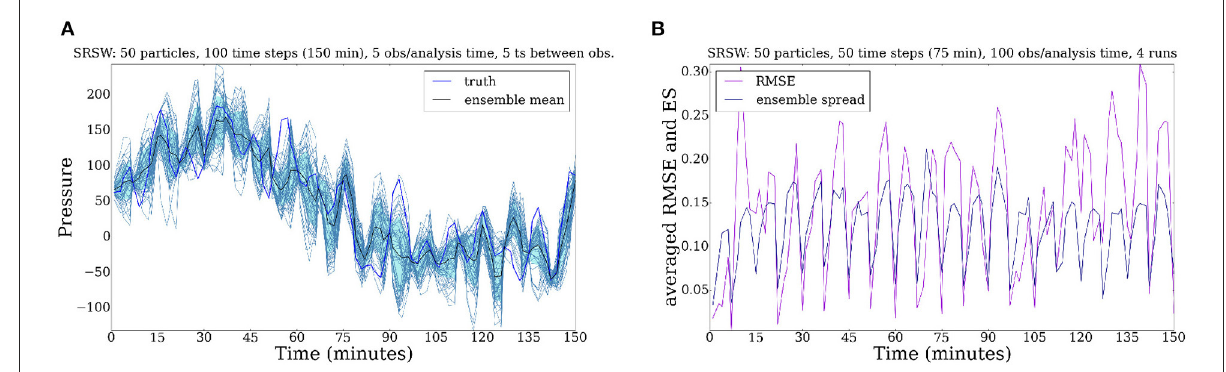
FIGURE12 Evolution of the SRSW model for 100 time steps. The system is observed every 5 time steps, with 5 observations/analysis time. The cloud of particles follows the truth most of the time. (A) Pressure field. (B) RMSE.